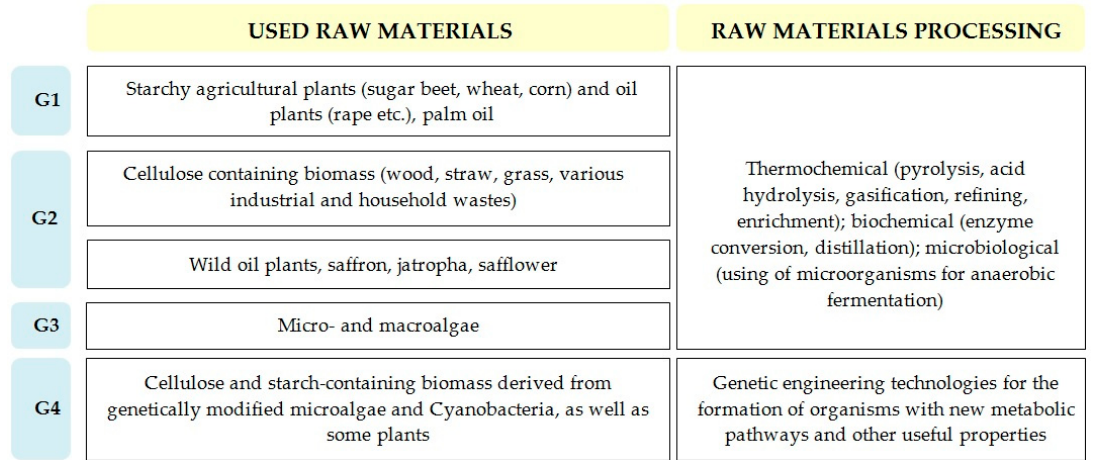
Figure 2. Scheme of the main steps made during the technological evolution in biofuel (BF) production. G1—first generation technologies [30,31,32,48–52]; G2—second generation technologies [34,39,49,52]; G3—third generation technologies [36,40–42,53–55]; G4—fourth generation technologies [45,47].